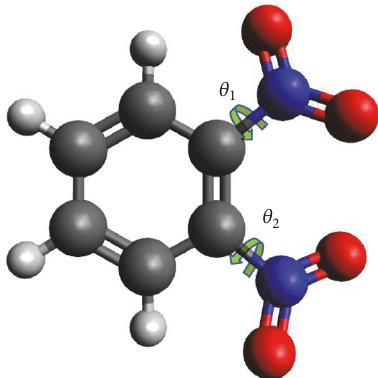
Figure 1: Molecular structure of orthodinitrobenzene and defini- tion of the coordinate system. The two-dimensional PESs depend on the angles 𝜃 1 and 𝜃 2 . The orthoisomer has the nitro groups at 1 and 2 positions, the metaisomer has them at 1,3, and the paraisomer has them at 1,4 (the figure was generated with the Avogadro software